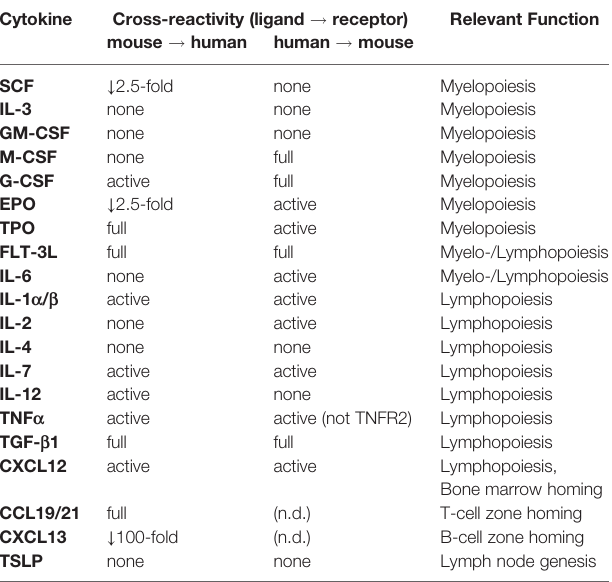
TABLE 1 | Cross-reactivity of human and mouse cytokines and their receptors. Cytokine Cross-reactivity (ligand ! receptor) Relevant Function mouse !